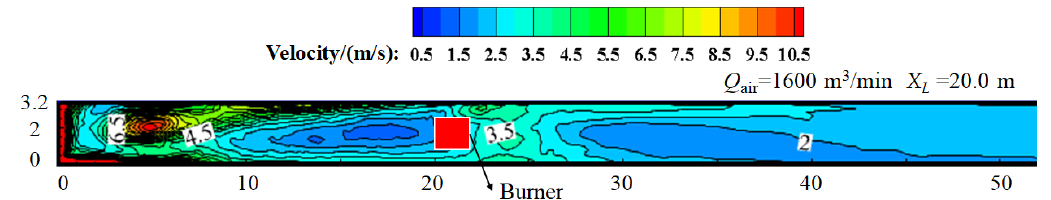
3 /min, X L = 20.0 air = 1600 m